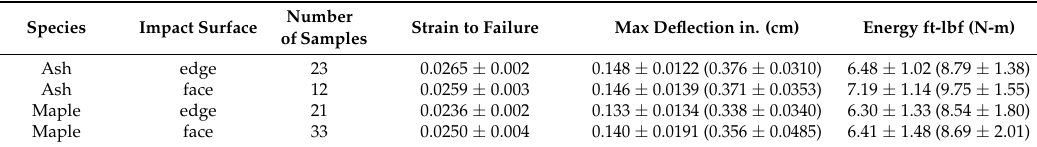
Table 1. Summary of mean values with one standard deviation for Charpy Impact testing of Major League Baseball (MLB)-quality Ash and